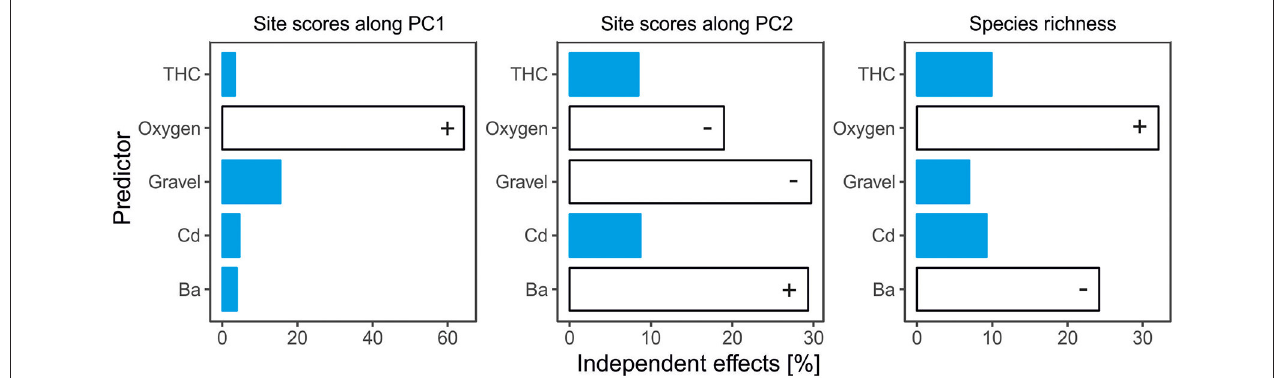
FIGURE 8 | Relative contribution of each environmental factor to shared variability of full models testing for effects of environmental factors on species composition (expressed as site scores along PCA ordination axes (1 and 2) and richness of cumaceans. Predictors that had significant effect on response variables are given in white. Plus ( + ) signs express positive impact of predictors on response variables, and minus (-) signs express negative influences. For full predictor names, see Supplementary Table 1 .